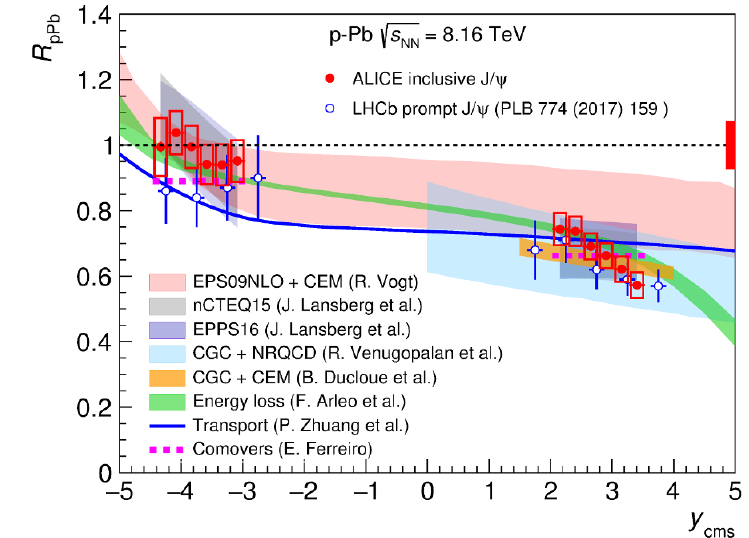
Figure 6 . Comparison of the ALICE and LHCb [47] results on the y cms -dependence of the J/ p nuclear modi(cid:12)cation factors in p{Pb and Pb{p collisions at s NN = 8 : 16 TeV. The horizontal bars correspond to the bin size. For ALICE, the vertical error bars represent the statistical un- certainties, the boxes around the points the uncorrelated systematic uncertainties, and the (cid:12)lled box around unity the correlated uncertainties. For LHCb, the vertical error bars represent the combination of statistical and systematic uncertainties. The results are also compared to several model calculations [34, 37, 62, 64{67] (see text for